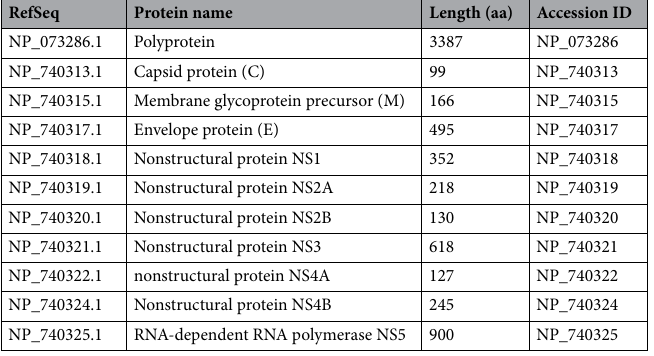
Table 1. Structural and non-structural protein sequences of DENV 4 retrieved from NCBI.